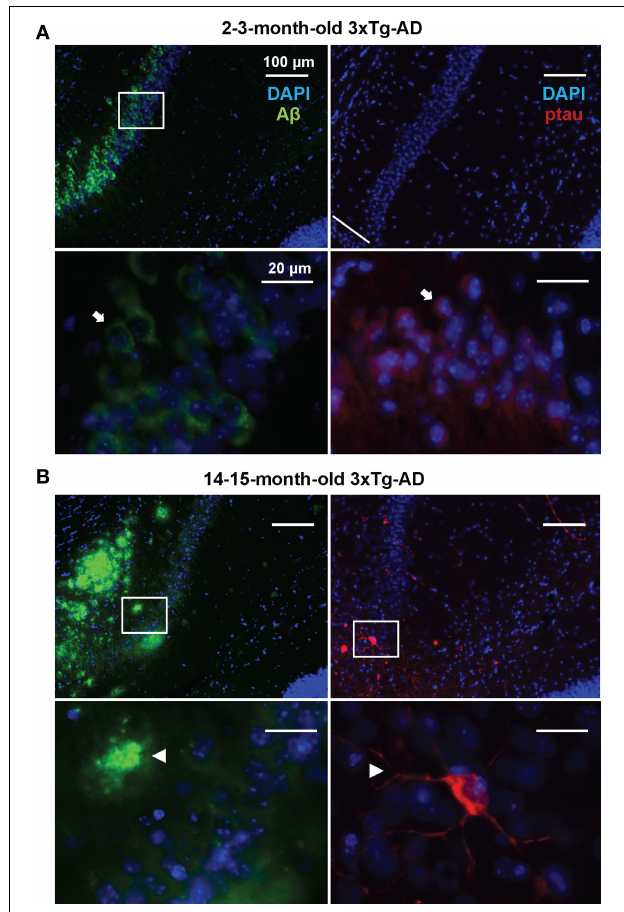
FIGURE 1 | Development of AD-like histopathological features in the 3xTg-AD. Brain coronal sections from the hippocampal CA1 field of 3x-Tg-AD mice. (A) Two- to three-month-old mice sections show A β (green) and p-tau (red) human transgene expression. Bottom panels correspond to magnifications of delineated regions in top images; arrows point at A β (left) and p-tau (right) immunostaining with no evidence of AD-like histopathological features. (B) Fourteen- to fifteen-month-old mice sections show extracellular aggregates of A β (green) and neuronal processes containing p-tau (red). Bottom panels correspond to magnifications of delineated regions in top images; arrowheads point at features indicative of the presence of AD histopathological hallmarks. Scale bars in (A) and (B) : 100 μ m (top images) and 20 μ m (bottom